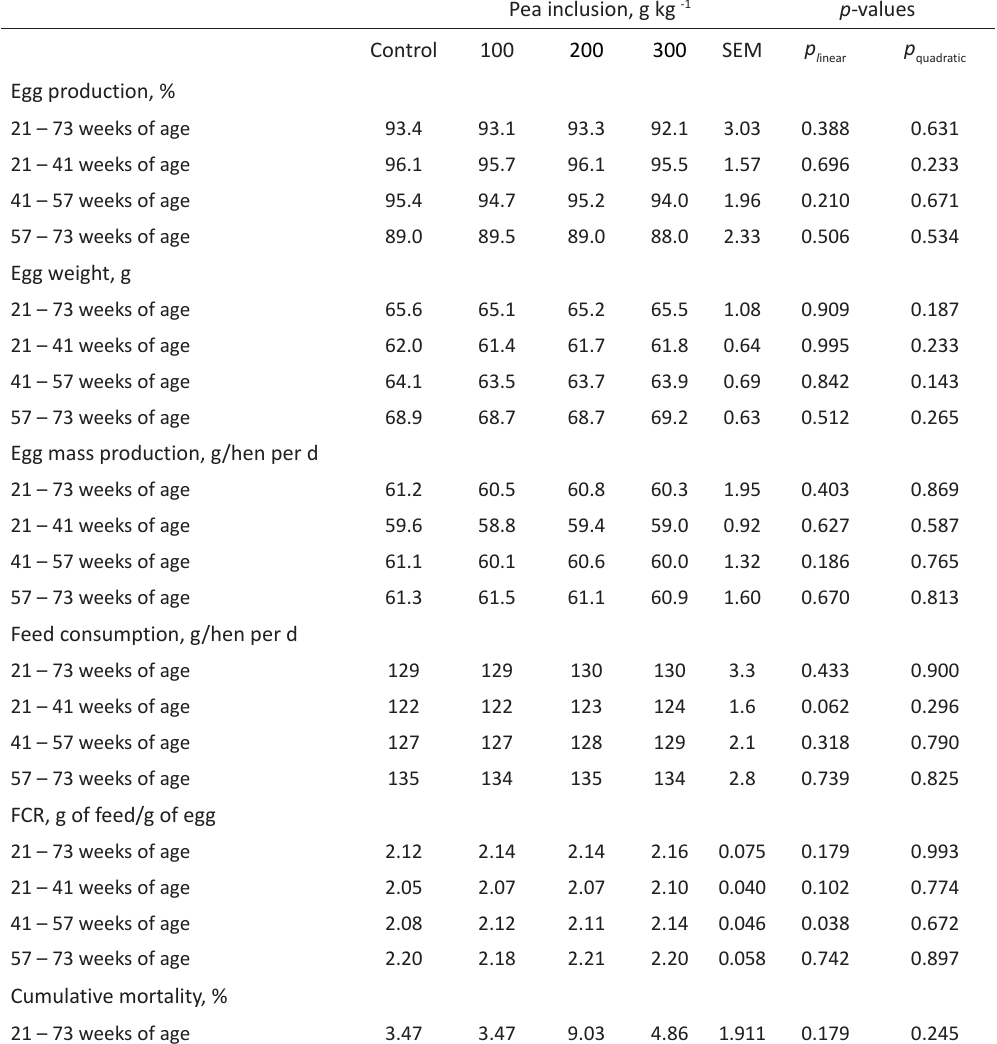
Table 4. The effects of dietary inclusion level of peas on laying hen egg production variables 1 Pea inclusion, g kg -1 p -values